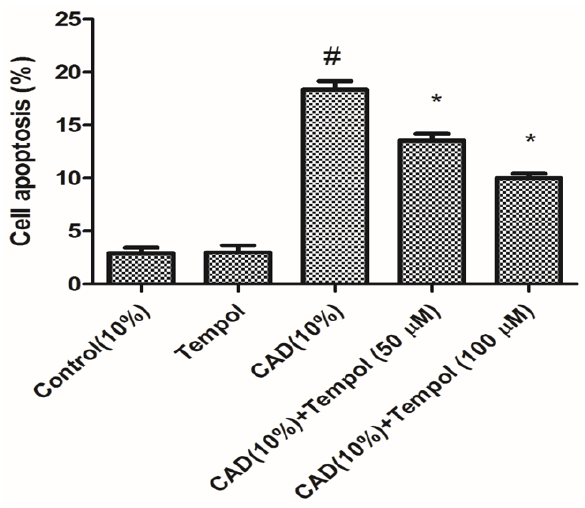
Figure 2: Effects of CAD serum on HUVEC apoptosis. HUVECs were cultured in 6-well plates with 10% CAD serum+ tempol (50 or 100 µM) for 24 h, and cell apoptosis was assessed by a FITC/PI assay. *p<0.05, **p<0.01 vs. Control group.